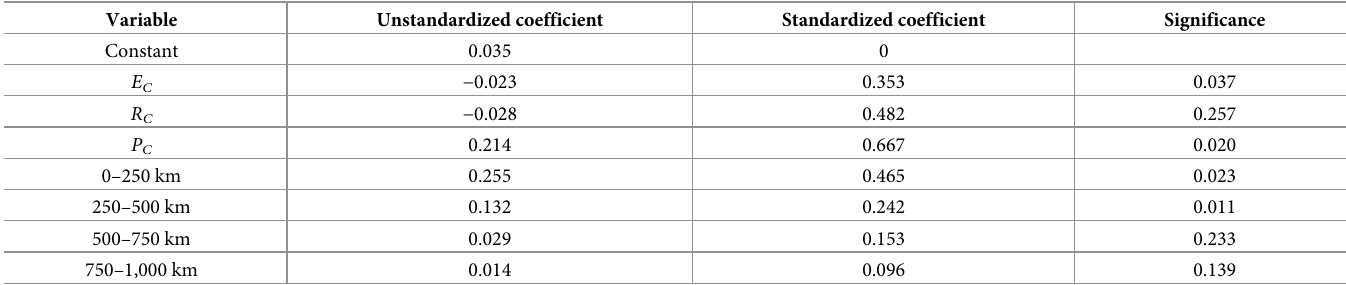
Table 7. QAP regression analysis about the distance